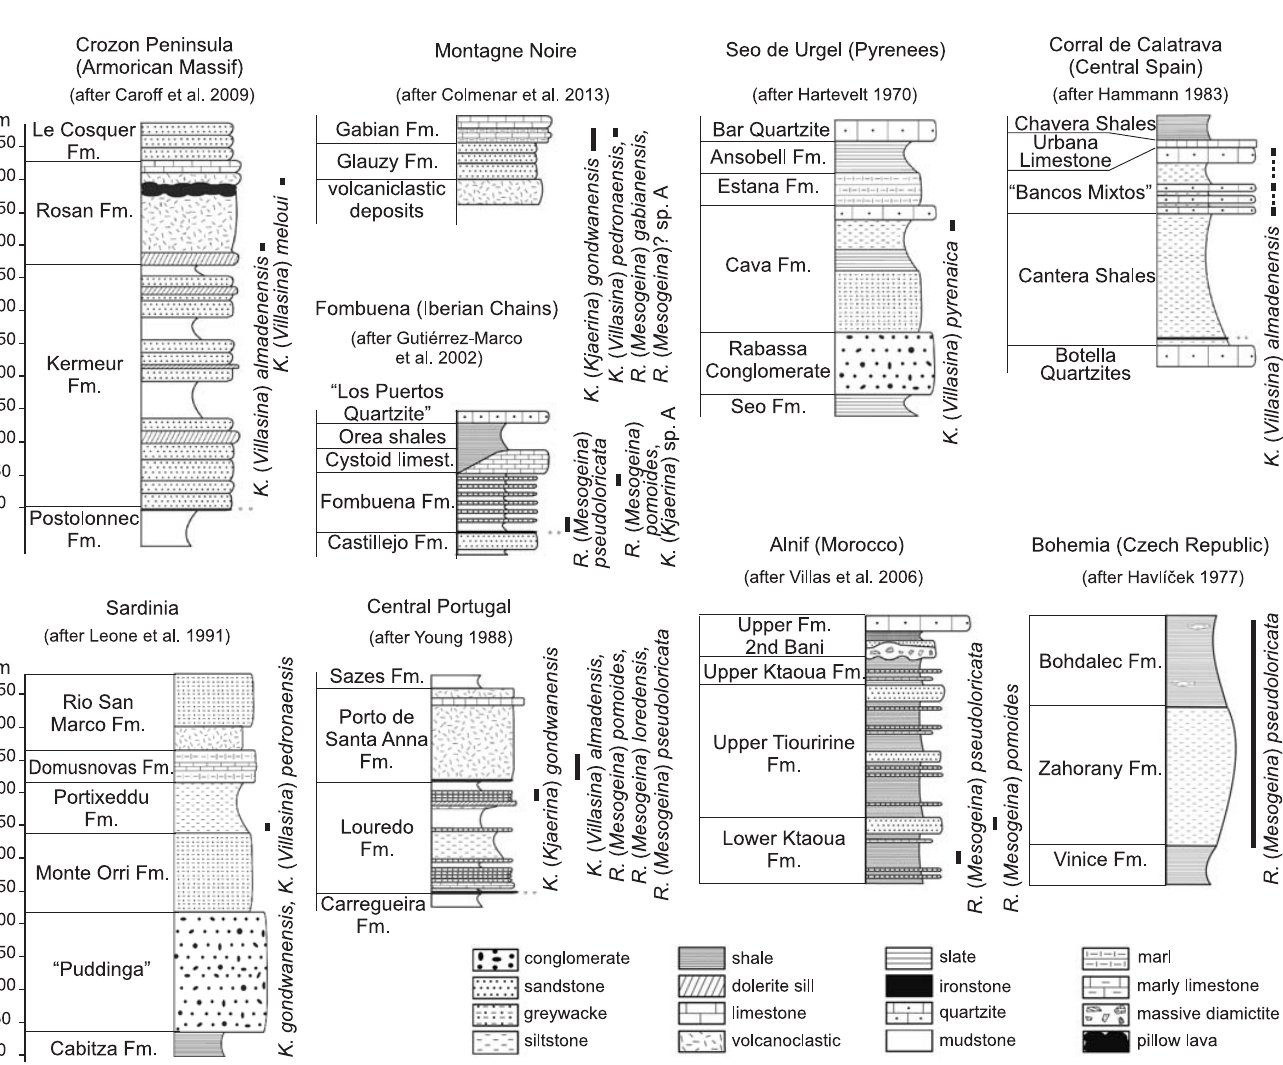
Fig. 1. Schematic stratigraphical columns and distributions of the taxa of subfamily Rafinesquininae in the most relevant SW Europe sections. Chrono- stratigraphical data of each section can be found in the referred